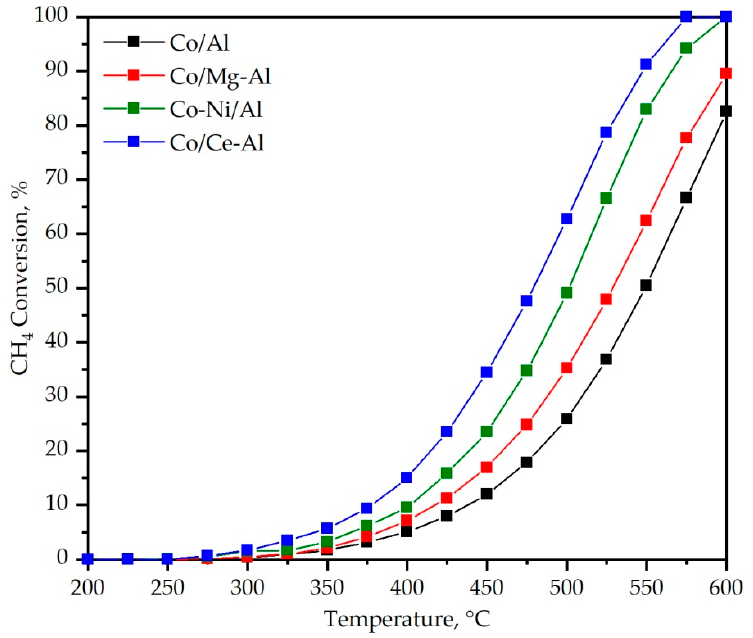
Figure 9. High angle annular dark field–scanning transmission electron microscopy (HAADF–STEM) images of the Co-Ni / Al ( left ) and Co / Ce-Al ( right ) catalysts coupled to electron energy loss spectroscopy (EELS; Co (red) and Ni (blue)) and energy dispersive X-ray spectrometry (EDX; Co (red) and Ce (green)) elemental distribution.